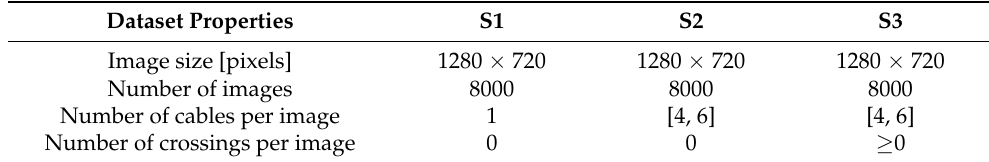
Table 2. Properties of the synthetic datasets generated by the visual replication for the scenarios S1, S2 and S3.